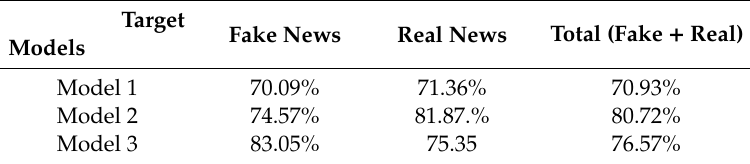
Table 7. Classification accuracy by classification